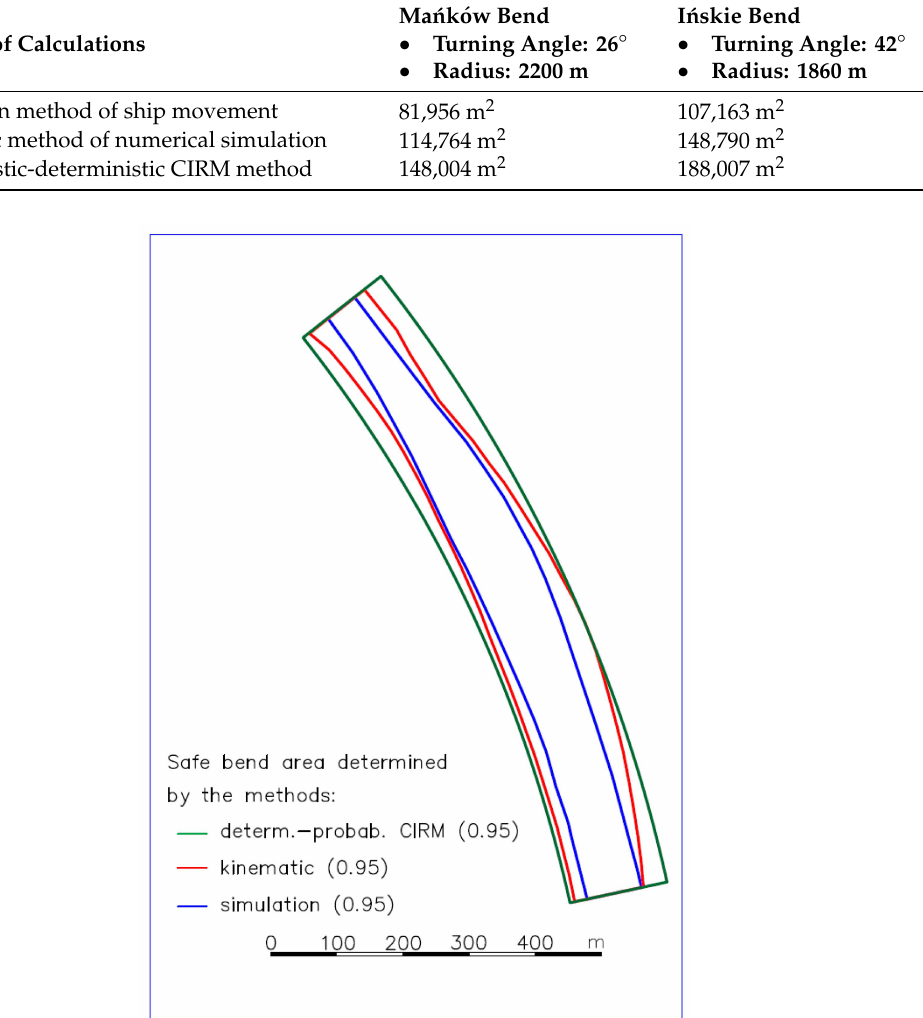
Method of Calculations